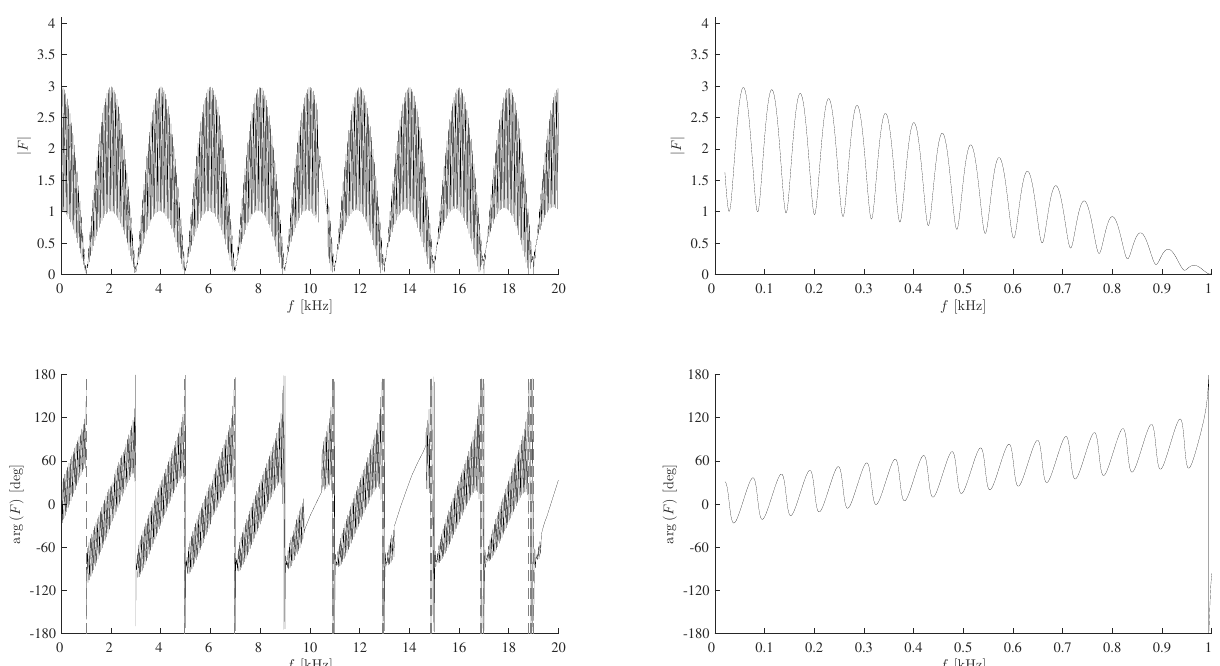
Figure 6: The same as Figure 3, but for halved reflection factor on the wall, R v = 0.5 .